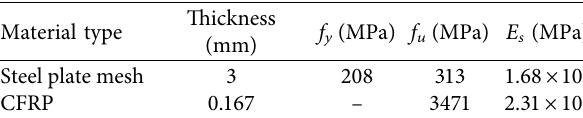
Table 4: Mechanical properties of strengthening